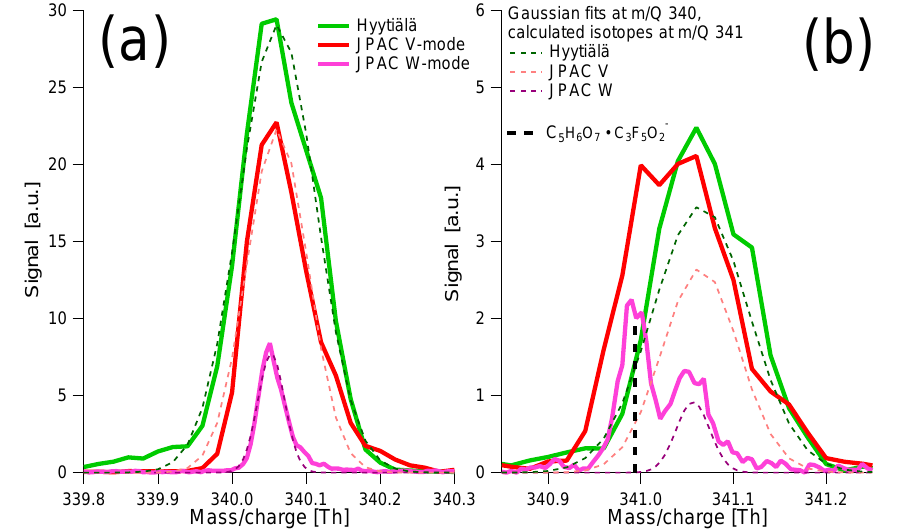
Fig. 4. Three different spectra, ambient night-time from Hyyti¨al¨a (green) and α -pinene chamber from JPAC in V-mode (red) and W-mode (purple), at UMR 340 (a) and 341Th (b) . Dashed lines in (a) depict Gaussian fits to the measured data (solid lines). Assuming that the peak at 340 Th is C 10 H 14 NO − , the corresponding isotopes at 341 Th are plotted as dashed lines in (b) . In Hyyti¨al¨a the peak at UMR 341Th is almost 12 completely explained by the isotope, whereas there is an interfering ion observed in JPAC. This ion was attributed to C 5 H 6 O 7 · C 3 F 5 O −